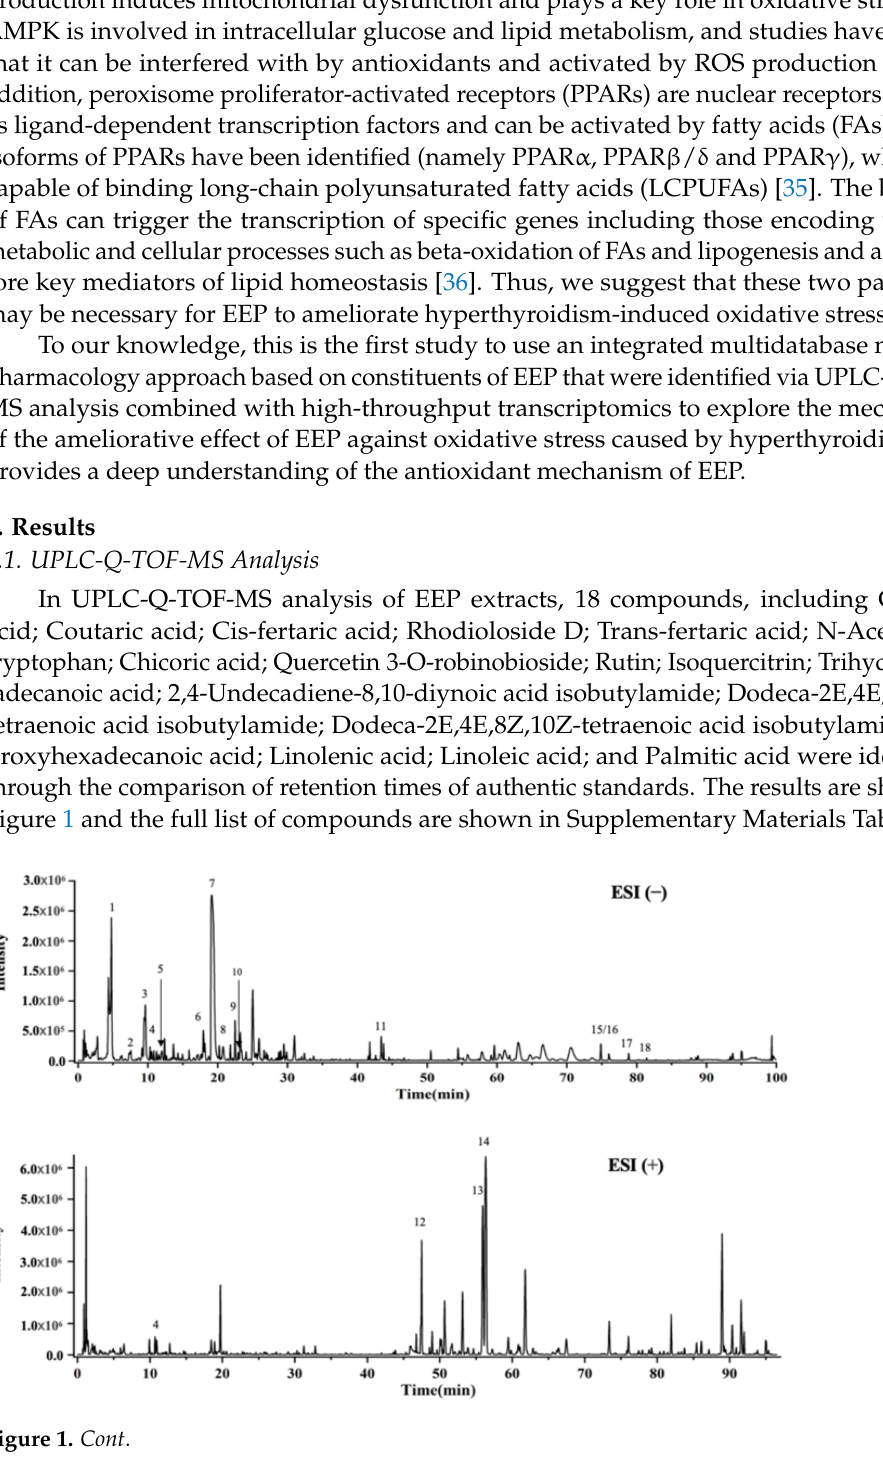
Figure 1. UPLC-Q-TOF-MS analysis of ethanolic extracts of Echinacea Purpurea . 1. Caftaric acid; 2. Coutaric acid; 3. Cis-fertaric acid; 4. Rhodioloside D; 5. Trans-fertaric acid; 6. N-Acetyl-DL-trypto- phan; 7. Chicoric acid; 8. Quercetin 3-O-robinobioside; 9. Rutin; 10. Isoquercitrin; 11. Trihydroxyoc- tadecanoic acid; 12. 2,4-Undecadiene-8,10-diynoic acid isobutylamide; 13. Dodeca-2E,4E,8Z,10E-tet- raenoic acid isobutylamide; 14. Dodeca-2E,4E,8Z,10Z-tetraenoic acid isobutylamide; 15. Hydroxy- hexadecanoic acid; 16. Linolenic acid; 17. Linoleic acid; and 18. Palmitic acid. 2.2. Effects of EEP on Body Weight Changes and Different Organ Weights in Hyperthyroidism Mice At the end of the experiment, the body weights of the mice in the model group de- creased significantly, compared to those of the control group ( p < 0.05). Furthermore, the body weights of the mice in the PTU treated group ( p < 0.05), the EEP-M treated group ( p < 0.05), and the EEP-H treated group ( p < 0.05) increased compared to the model group. The spleen weights index in the model group rats decreased significantly compared to the control group ( p < 0.05), while EEP-M treatment ( p < 0.01) increased spleen weight index. However, EEP did not change the weight of the thymus glands (Figure 2).